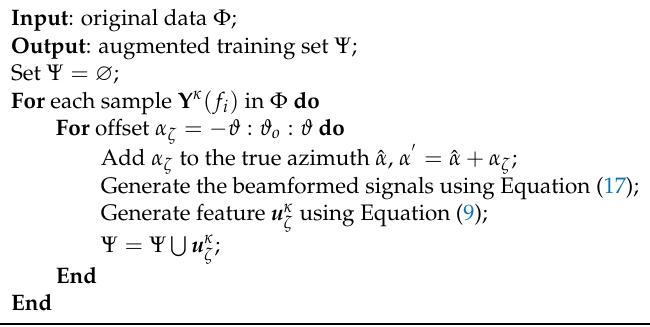
Table 1. Algorithm 1: data augmentation